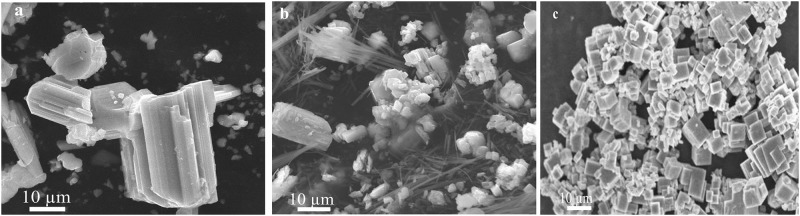
Effect of temperature on the morphology and size of NaNbO3.(a) 150°C. (b) 180°C. (c) 200°C.